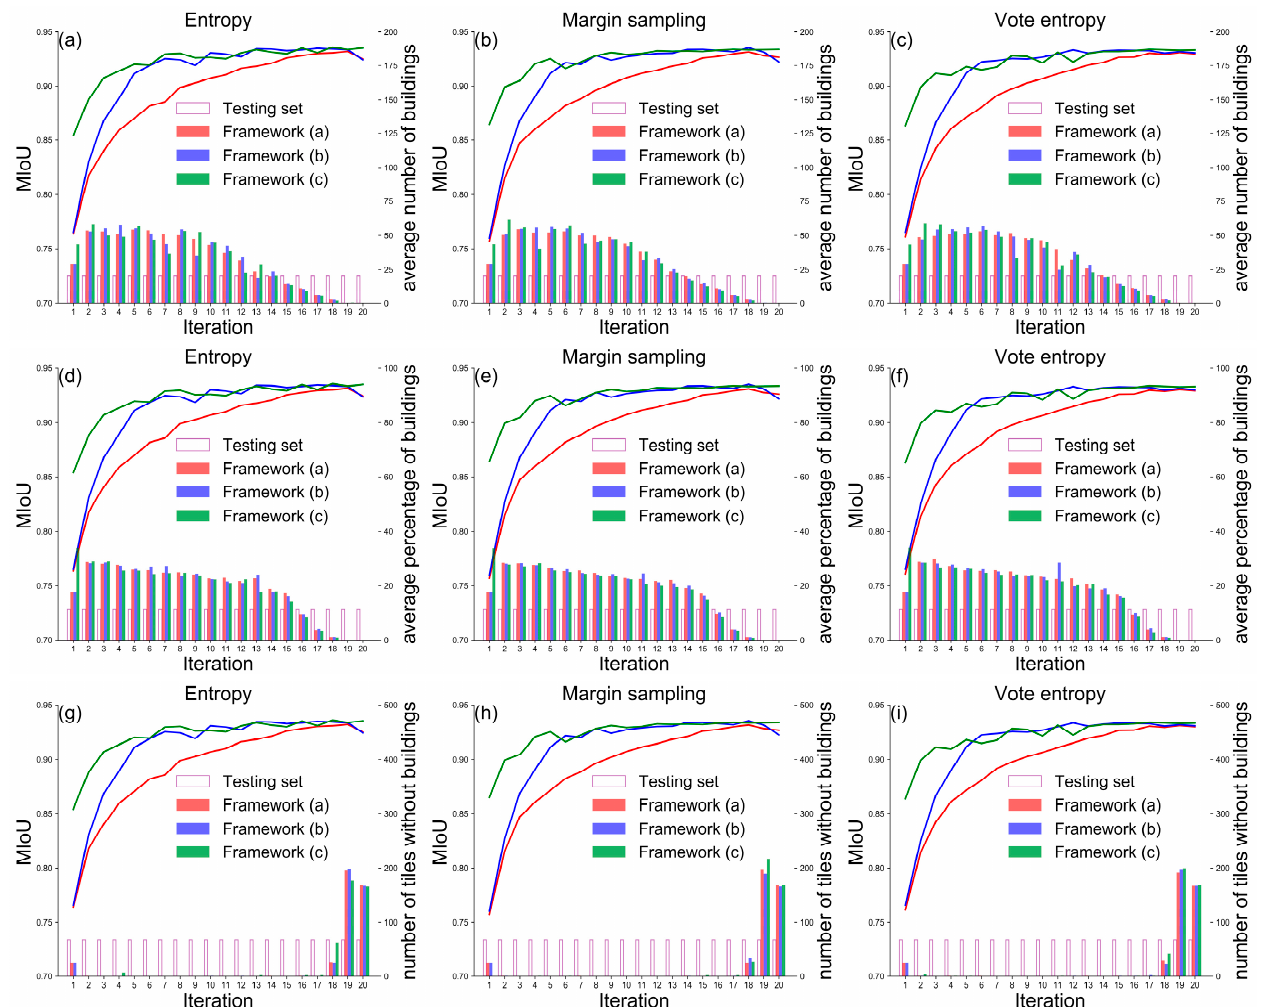
Figure 8. Comparison of performance of the three frameworks based on WHU aerial building dataset in terms of mIoU, the average number of buildings, the average percentage of building area, and the number of tiles without buildings. The X -axis represents the percent of training data used for model training. The left Y -axis represents the value of mIoU in each iteration. The right Y -axis represents the landscape metric values per